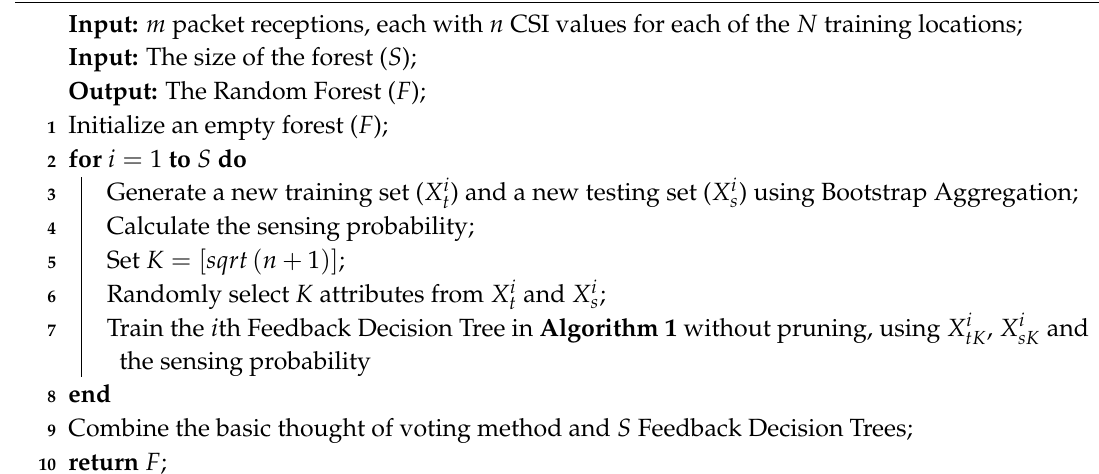
Algorithm 2. Random Forest construction with Feedback Decision